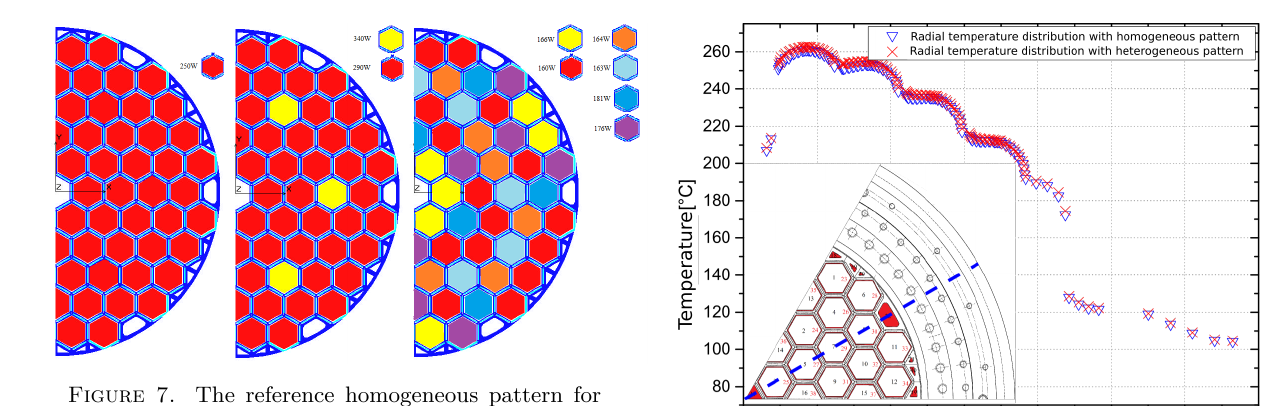
Table 2. Comparison of measured temperatures on the SC No. 10 and temperatures calculated by the COBRA-SFS heat-removal model